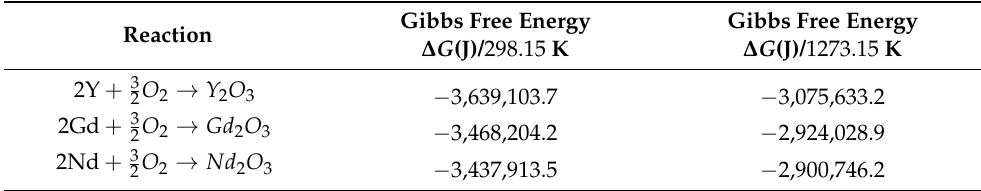
Table 4. The Gibbs free energy calculated by Factsage software.